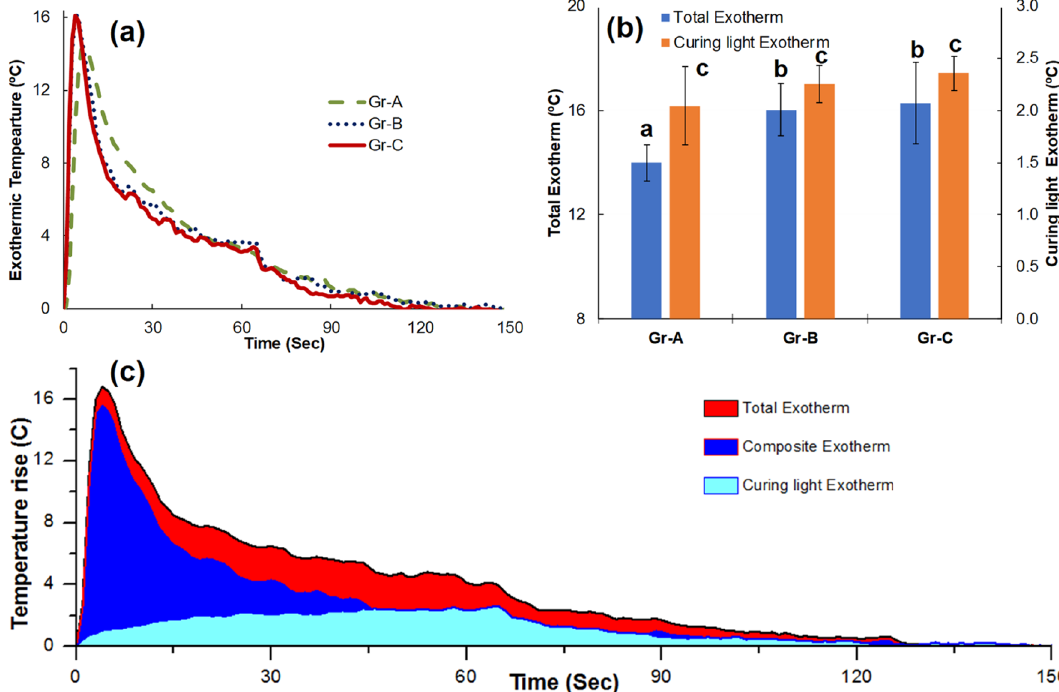
Figure 4. Exotherm profile for ( a ) Variation of total exotherm over time for first 150 s ( b ) Mean and standard deviation values of first and second irradiation exotherm for three groups where the groups with the same alphabets are not significantly different from each other (p > 0.05) ( c ) Superposition of temperature–time profile for total exotherm, composite exotherm and curing light contribution for the sample from Gr-C.